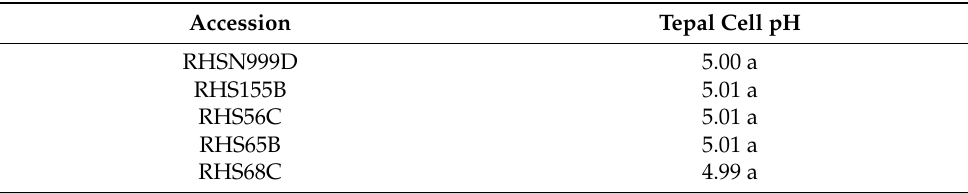
Table A1. Tepal cell pH measured on five A. pallida accessions.